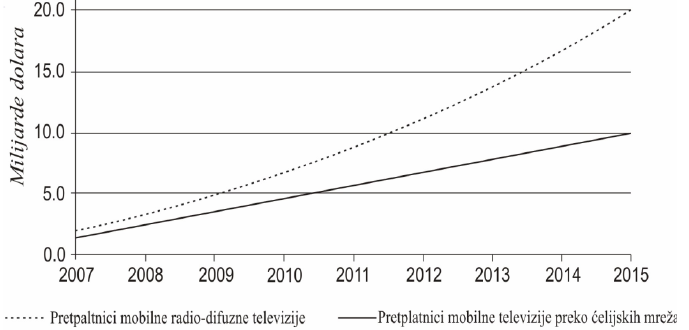
Figure 2 – Expected mobile TV profit growth rate worldwide Dosadašnja